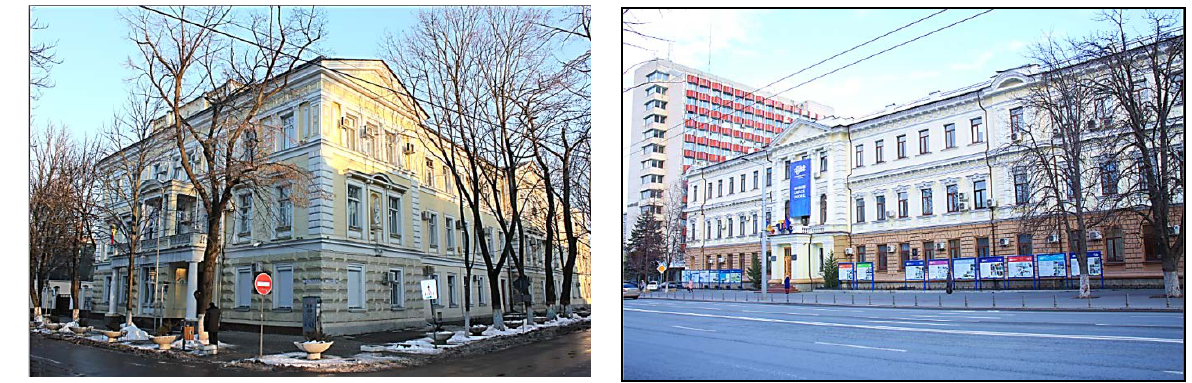
Figure 1. The District Court,1885. Figure 2. The Treasury Chamber, 1903.